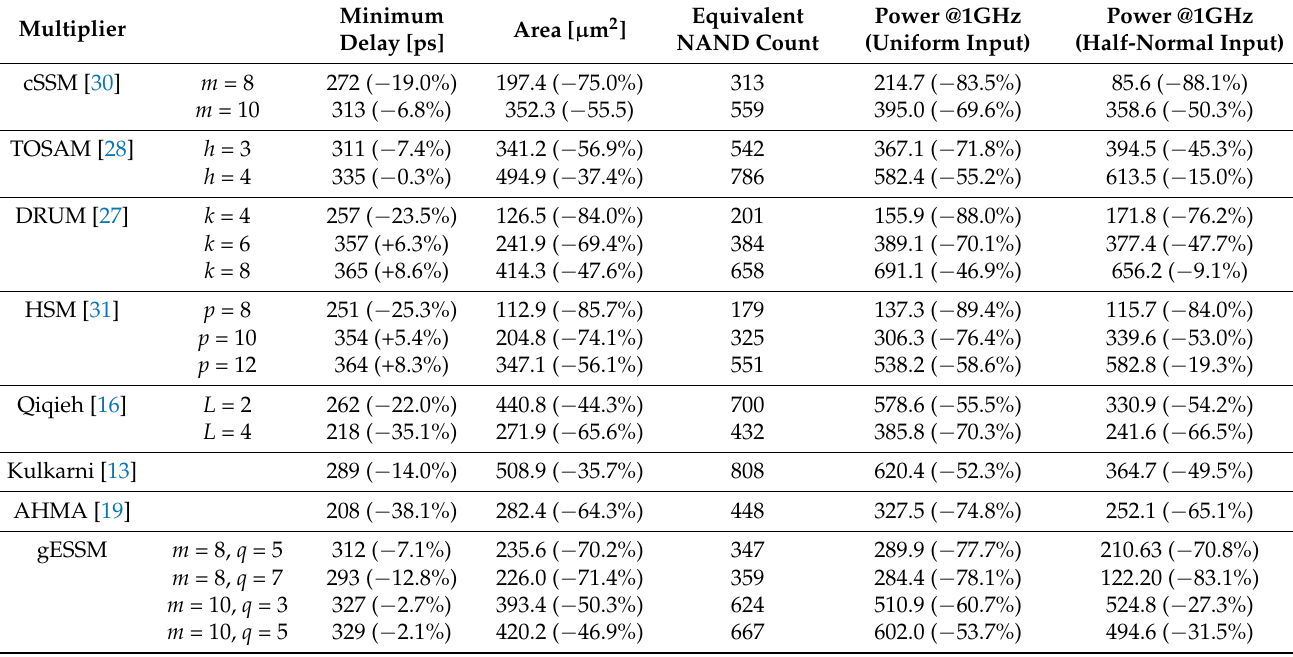
Figure 7a,b report the coefficients of h GAUSSIAN and h MOTION , expressed as integer numbers on n = 16 bits.